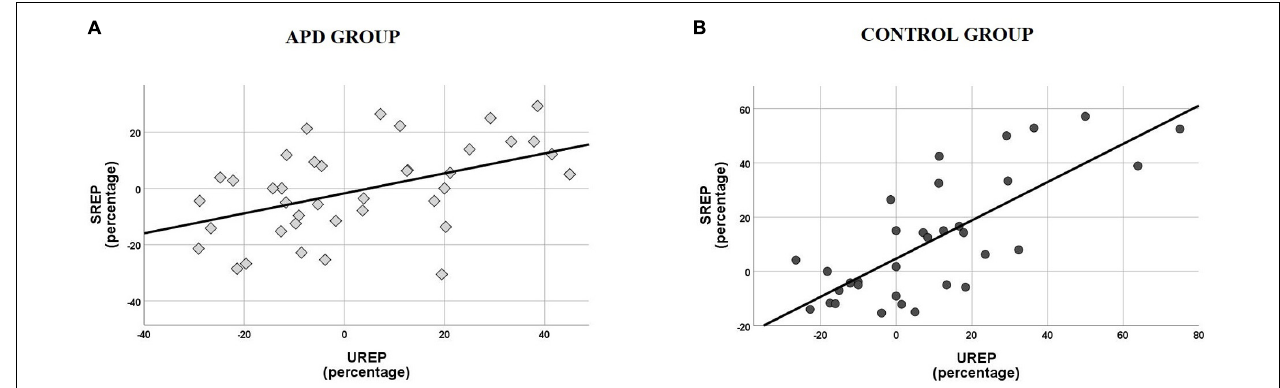
FIGURE 3 | (A) Scatterplot of SREP vs. UREP scores for APD group. Correlation is r = 0.492, thus the two measures share ∼ 24% of their total of variance. (B) Scatterplot of SREP vs. UREP scores for control group. Correlation is r = 0.754, thus the two measures share ∼ 57% of their total of variance. SREP, synchronized rhythm effect percentage; UREP, un-synchronized rhythm effect